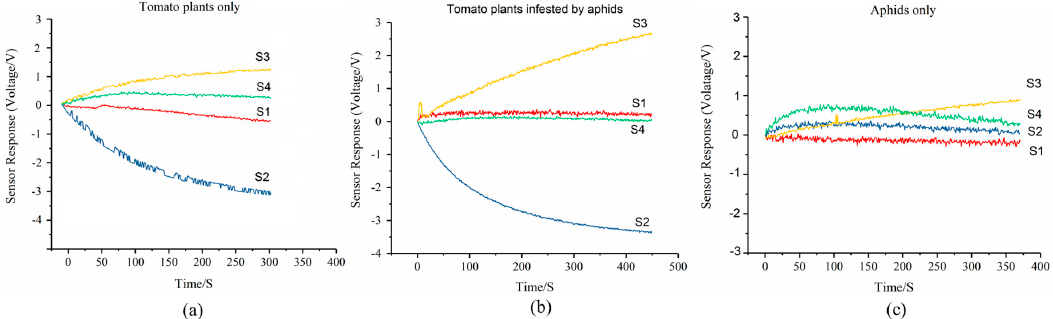
Figure 4. Sensor performance of the developed E-nose system for the healthy tomato plant ( a ), aphid-infested tomato plant ( b ), and aphids only ( c ) (sensor 1(S1), sensor 2(S2), sensor 3 (S3), and sensor 4 (S4)).